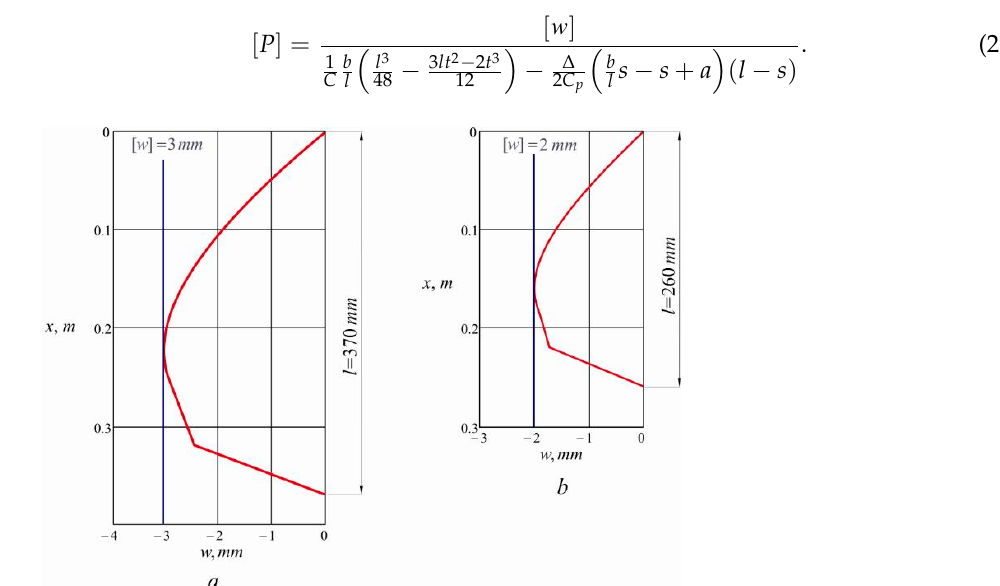
Figure 7. Deflections of the broken fibula, fixed with an extracortical plate: ( a ) the permissible value of tightrope tightening force for a tall person is [ P ] = 66 N; ( b ) the permissible value of tightrope tightening force for a small person is [ P ] = 28 N.